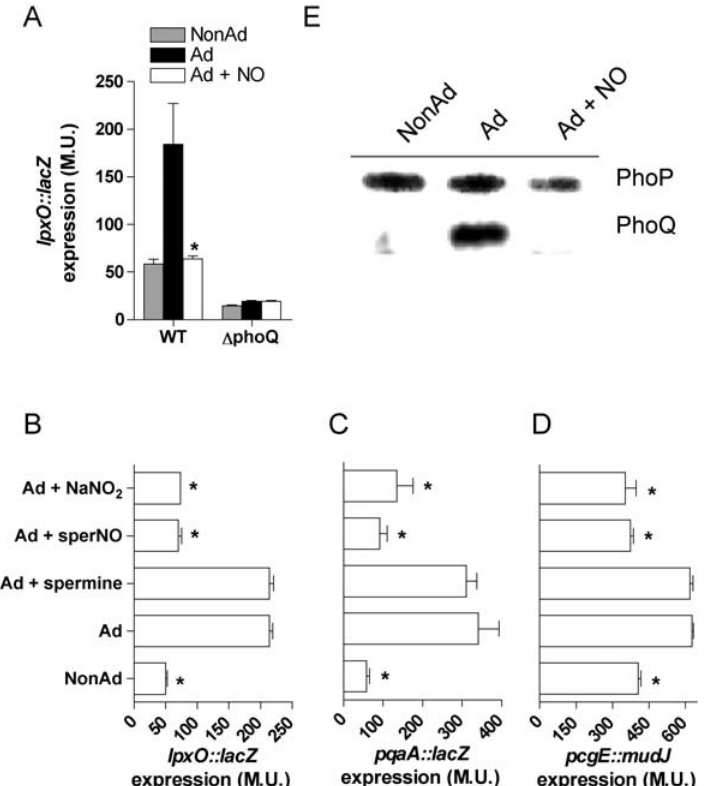
Figure 6. Suppression of PhoPQ-dependent gene transcription is mediated by nitrogen oxides and requires an intact signal transduction cascade. The effect of spermine NONOate on the PhoPQ-dependent induction of the lpxO::lacZ transcriptional fusion is shown in , panel A. b -galactosidase activity (Miller Units, M.U.) is represented as the mean 6 SEM of 4–6 independent observations from 2–3 separate experiments. *, p , 0.002 compared to adapted controls. The acid-inducible expression of the PhoP-activated loci lpxO , pqaA and pcgE